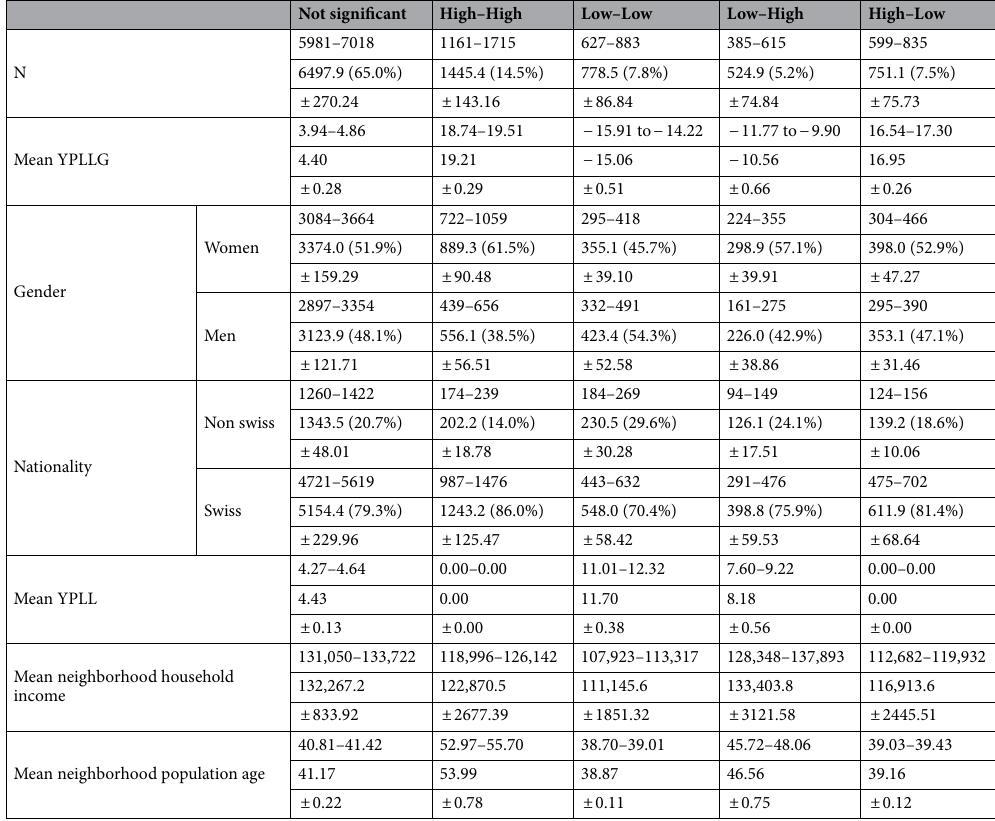
Table 1. Characteristics of individuals within each Local Moran cluster type for the raw YPLLG model. For each variable, the table shows range, mean, and standard deviation, calculated across the ten subsets. The totals per category may not be equal to 10,000 due to neighborless individuals who were excluded from the Local Moran’s